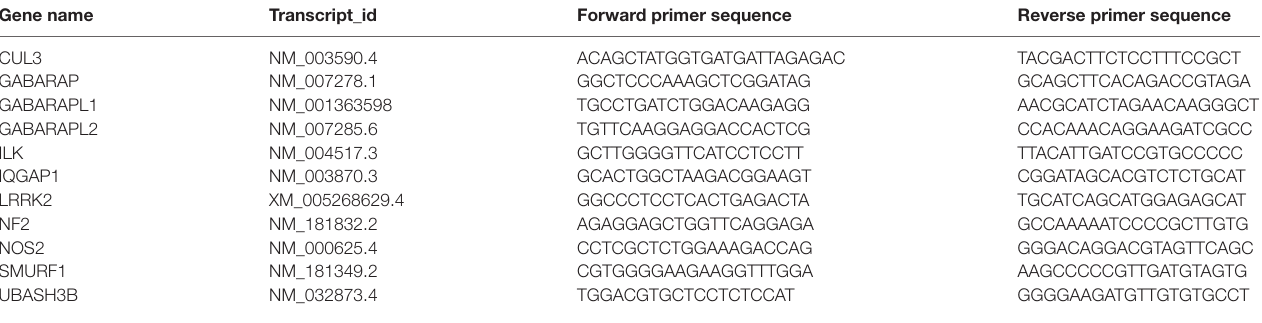
TABLE 1 | Primers used for qPCR quantification of siRNA